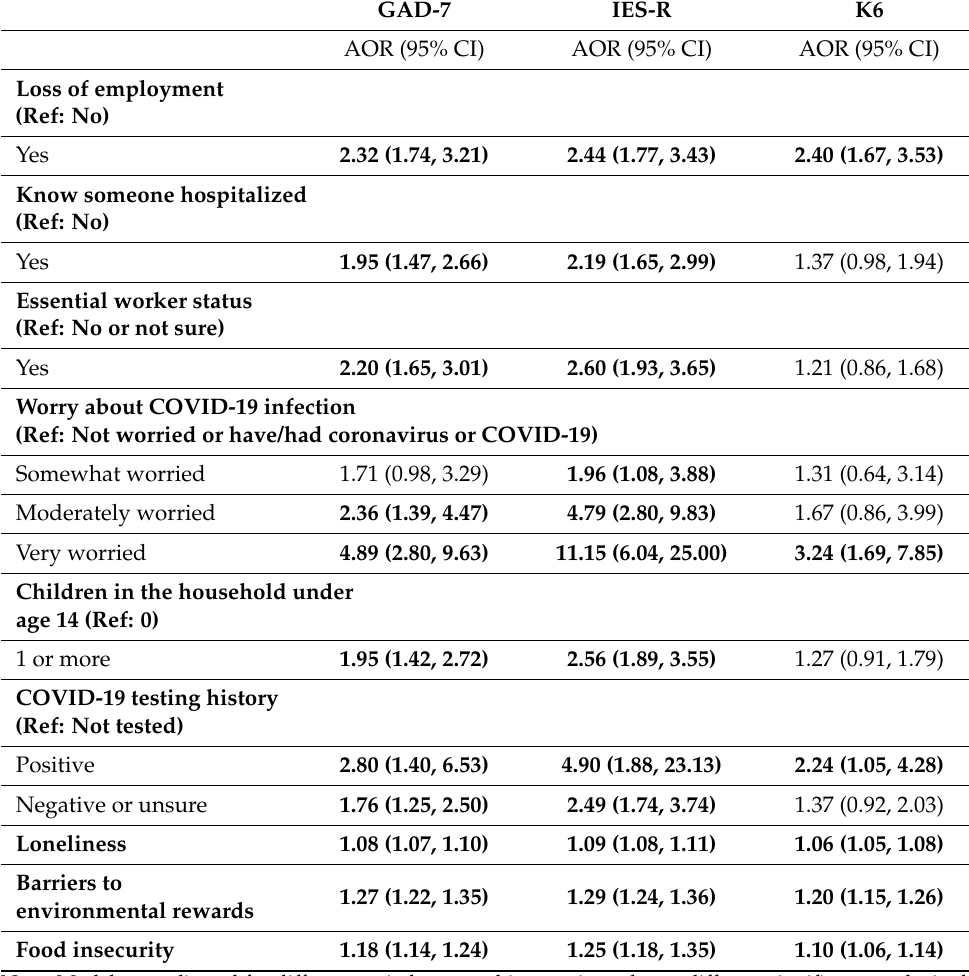
Table 4. Partially adjusted logistic regression models testing associations of sociodemographic characteristics and individual COVID-19-related stressors with mental health